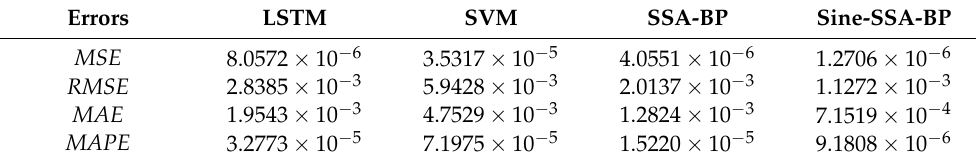
Table 4. Comparison of trajectory prediction errors in Scenario